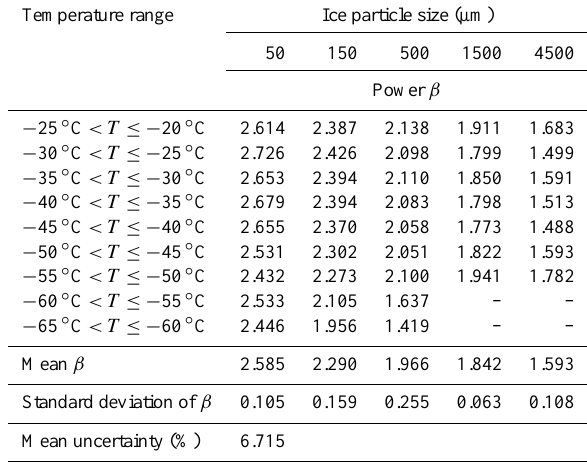
Table 3. Uncertainty estimates for mass-dimension power β for synoptic cirrus clouds.